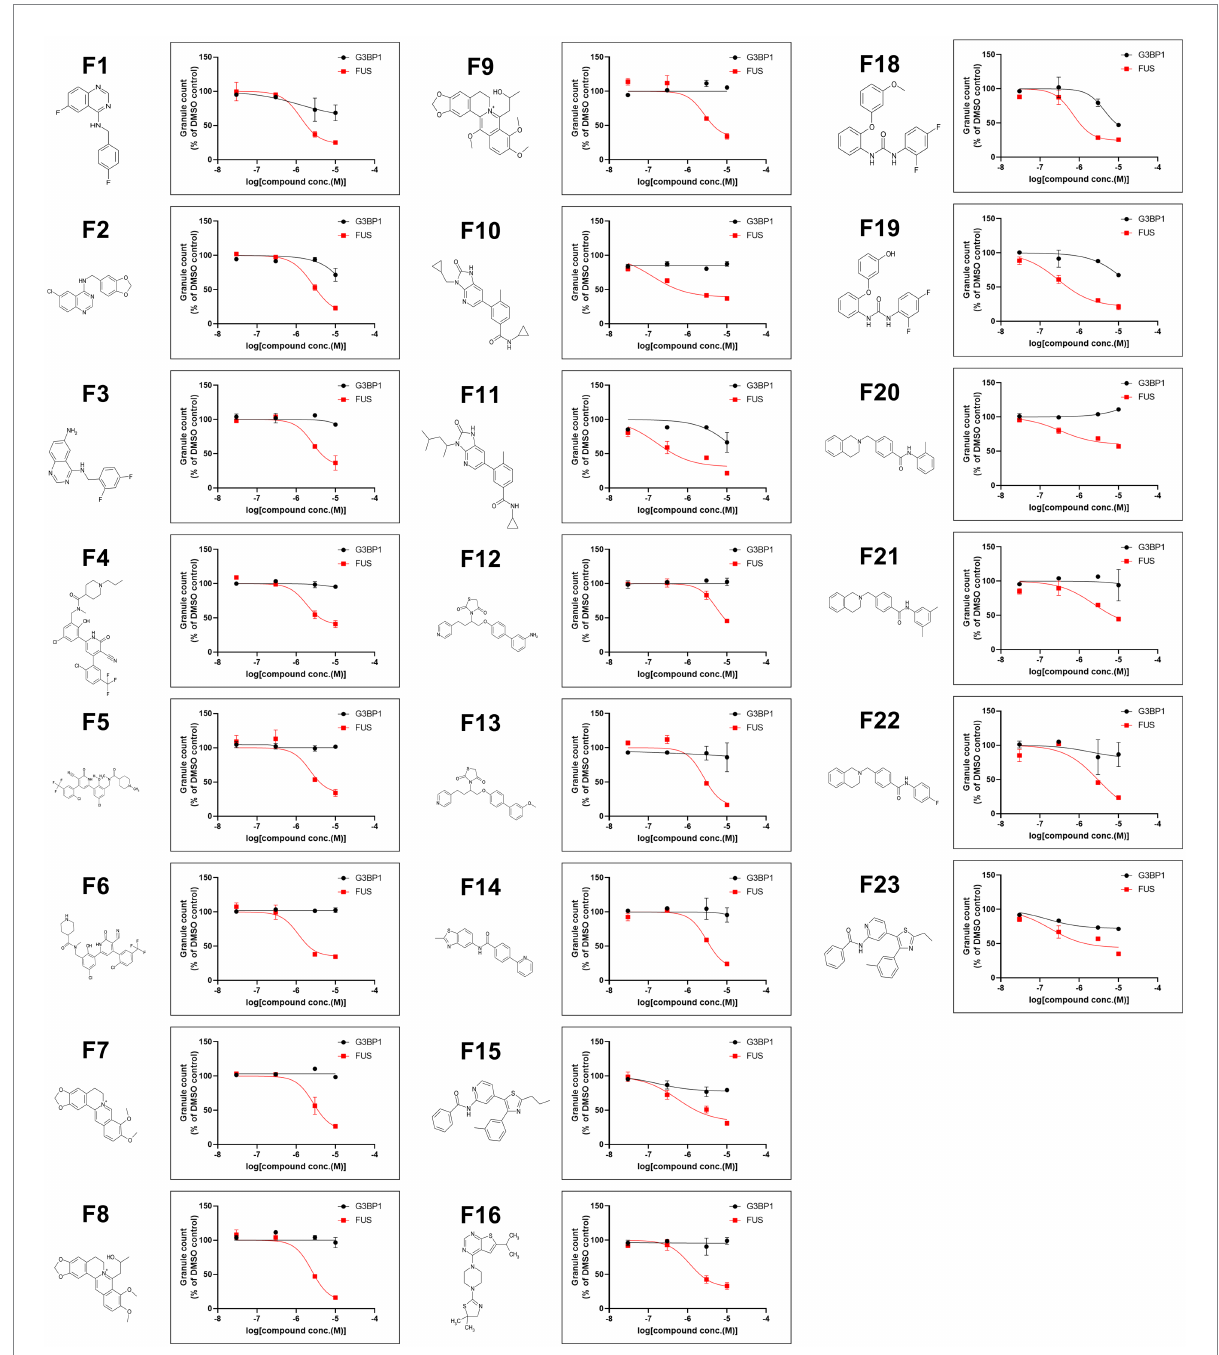
FIGURE 6 A list of 23 hit compounds that inhibit FUS-positive SG formation. Structures of the 23 hit compounds except for F17 are shown in Figure 5B and dose-response curves for reduced mislocalization of FUS P525L at cytosolic